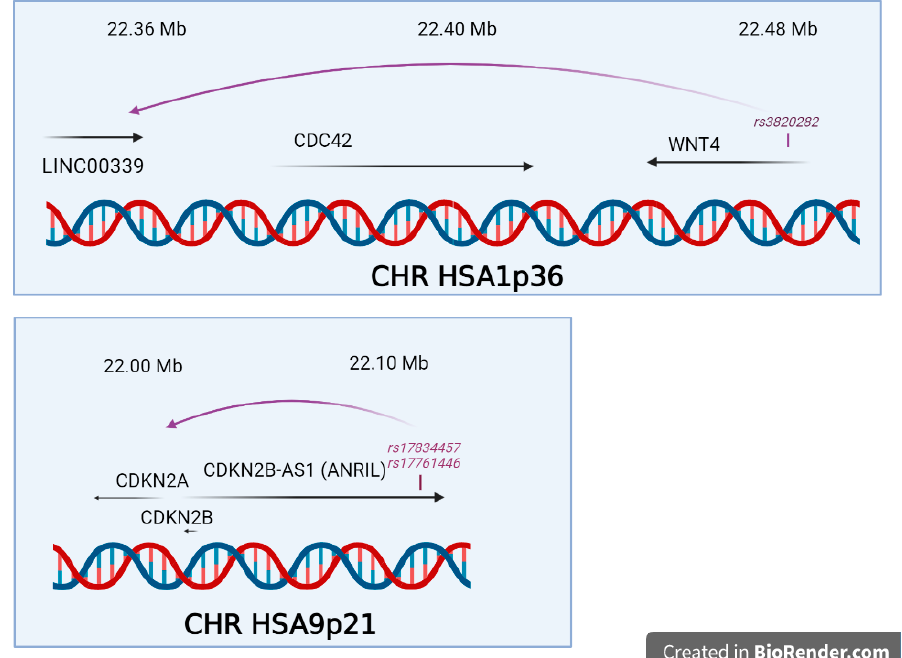
Figure 3. The two situations for which mechanistical insights were obtained on the functional effects of the significant SNPs. In both cases through chromatin structure approaches, such as 3C, the impact of the SNPs on adjacent genes was analysed in detail (created in BioRender.com).